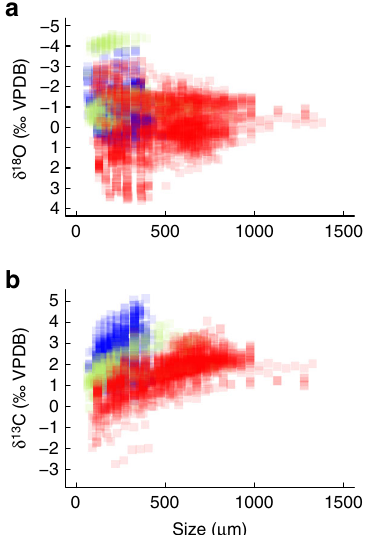
Fig. 1 Planktonic foraminiferal body size and stable isotope values over the past 107 million years. Multispecies compilation of size-speci fi c oxygen ( a ) and carbon ( b ) isotope trends (Supplementary Data 1). The data are color coded for visualization purposes only; Quaternary-Neogene – Oligocene (red), Paleocene – Eocene (blue), and the Cretaceous